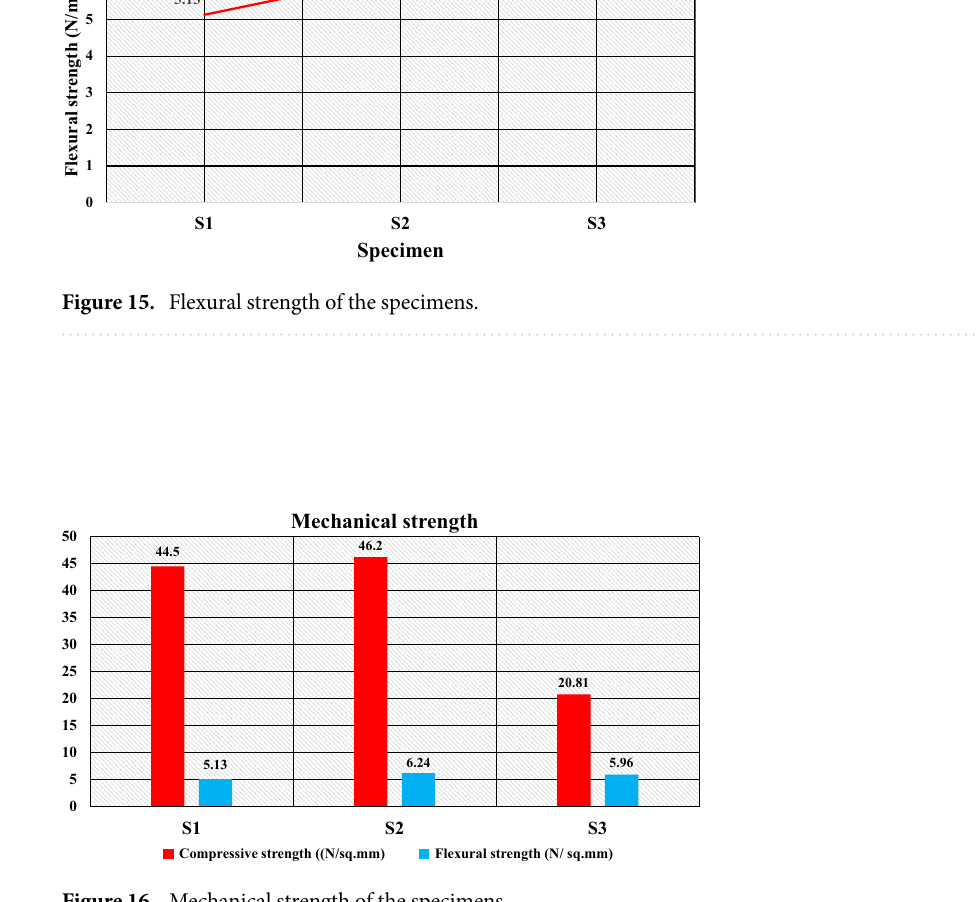
Figure 16. Mechanical strength of the